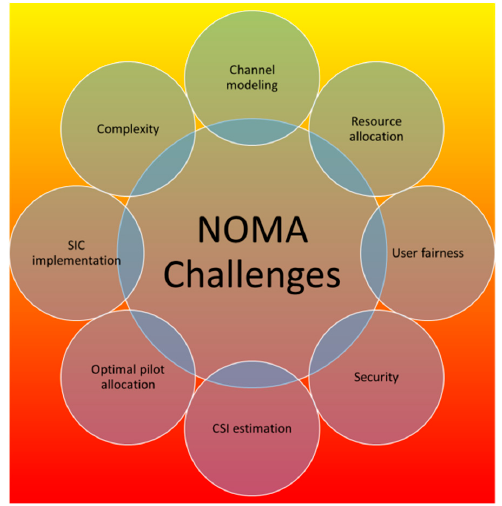
Figure 13. Basic challenges in NOMA .